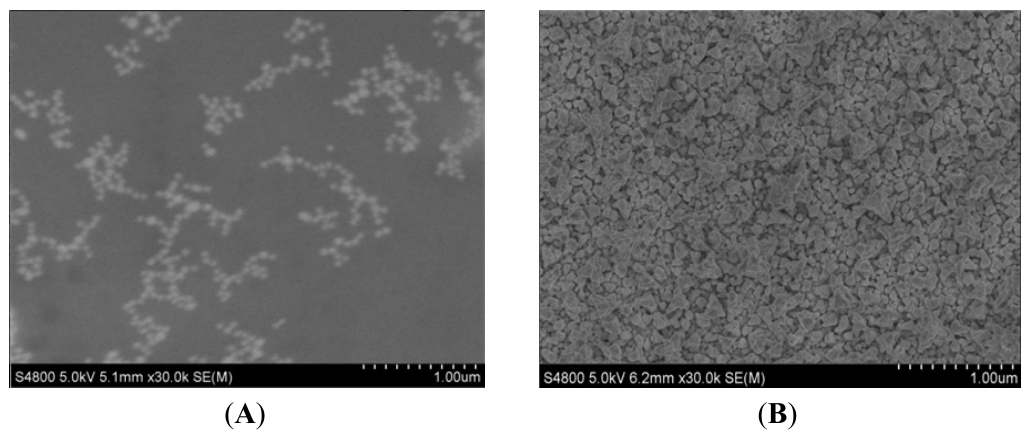
Figure 1. SEM images of GNPs film ( A ) and DpAu film ( B ) on Au